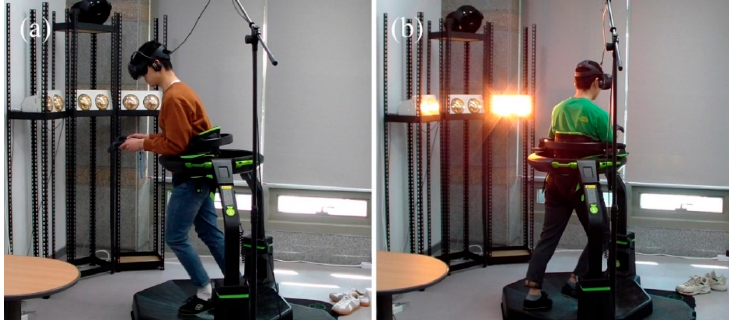
Figure 2. Images of ( a ) a learner playing the basic fire safety education Virtual Reality (VR) game and of ( b ) a learner playing the fire safety education VR game with cutaneous sensation [10]. Copyright © 2020, Springer-Verlag London Ltd.